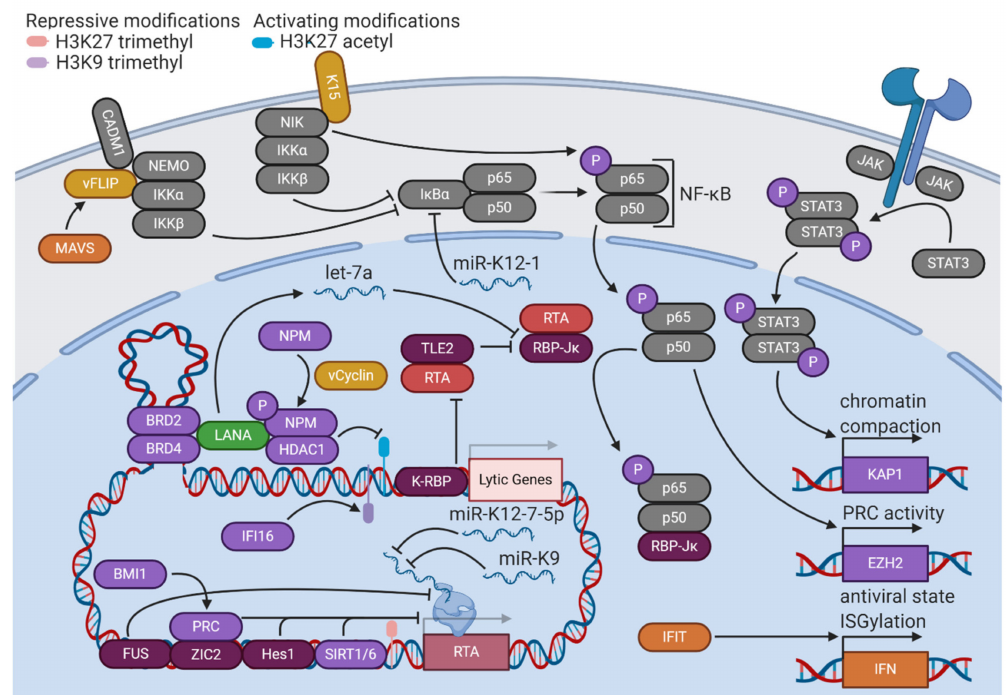
Figure 2. KSHV modulates host signaling pathways, chromatin structure, and gene expression to maintain latency. Viral proteins and miRNAs stimulate latency-promoting signaling pathways and chromatin modifiers. The expression and function of RTA is restricted by a variety of proteins and miRNAs from the virus and the host. LANA promotes repressive histone modifications and regulatory loops. Lytic gene expression is minimal but poised for reactivation upon shifts in the relative activities of RTA and